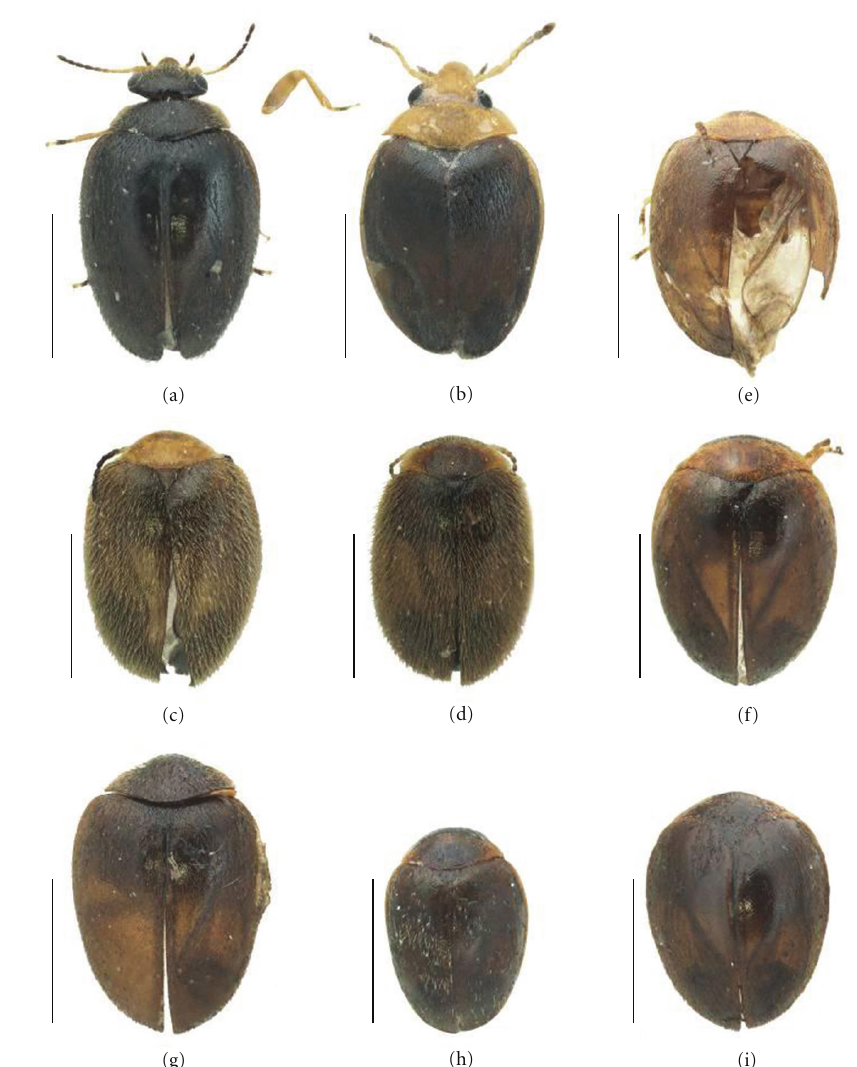
Figure 1: Habitus of Hydrocyphon spp., holotypes, male (a, c, e–i) and paratypes, female (b, d). (a, b) H . jogjaensis sp.n.; (c, d) H . takizawai sp.n.; (e) H . sagittiger sp.n.; (f) H . serratibasialis sp.n.; (g) H . doiinthanonensis sp.n.; (h) H . klapperichi sp.n.; (i) H . deformis sp.n. Scale = 1.0mm. Table 2: The list of the species excluding from the genus Hydrocyphon . An Excel file version is also available at the following URL: https:// sites.google.com/site/waterbeandlesofjapan/home/support-files-on-articles/Appendix 2.xls.